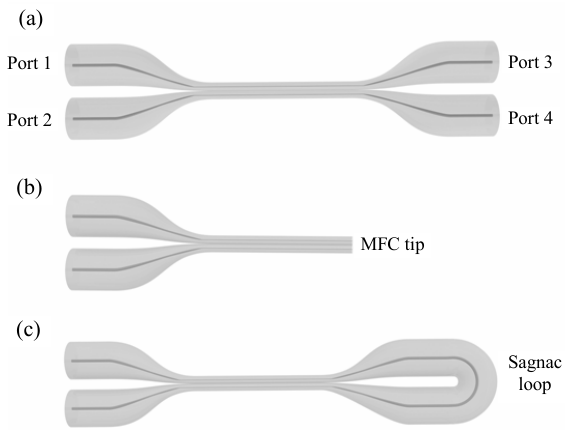
Fig. 3 Schematic of optical microfiber coupler (MFC) structures: (a) typical structure of MFC, (b) MFC probe, manufactured by cleaving the waist, and (c) Sagnac loop mirror, manufactured by fusing the